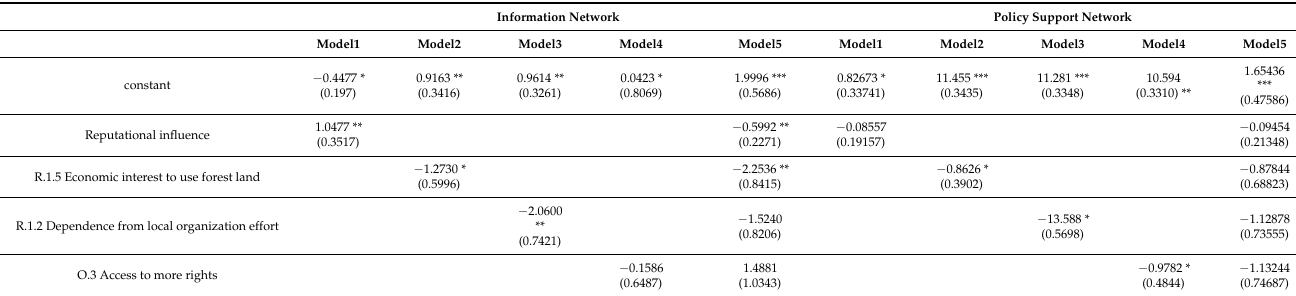
Table 6. Logit results.